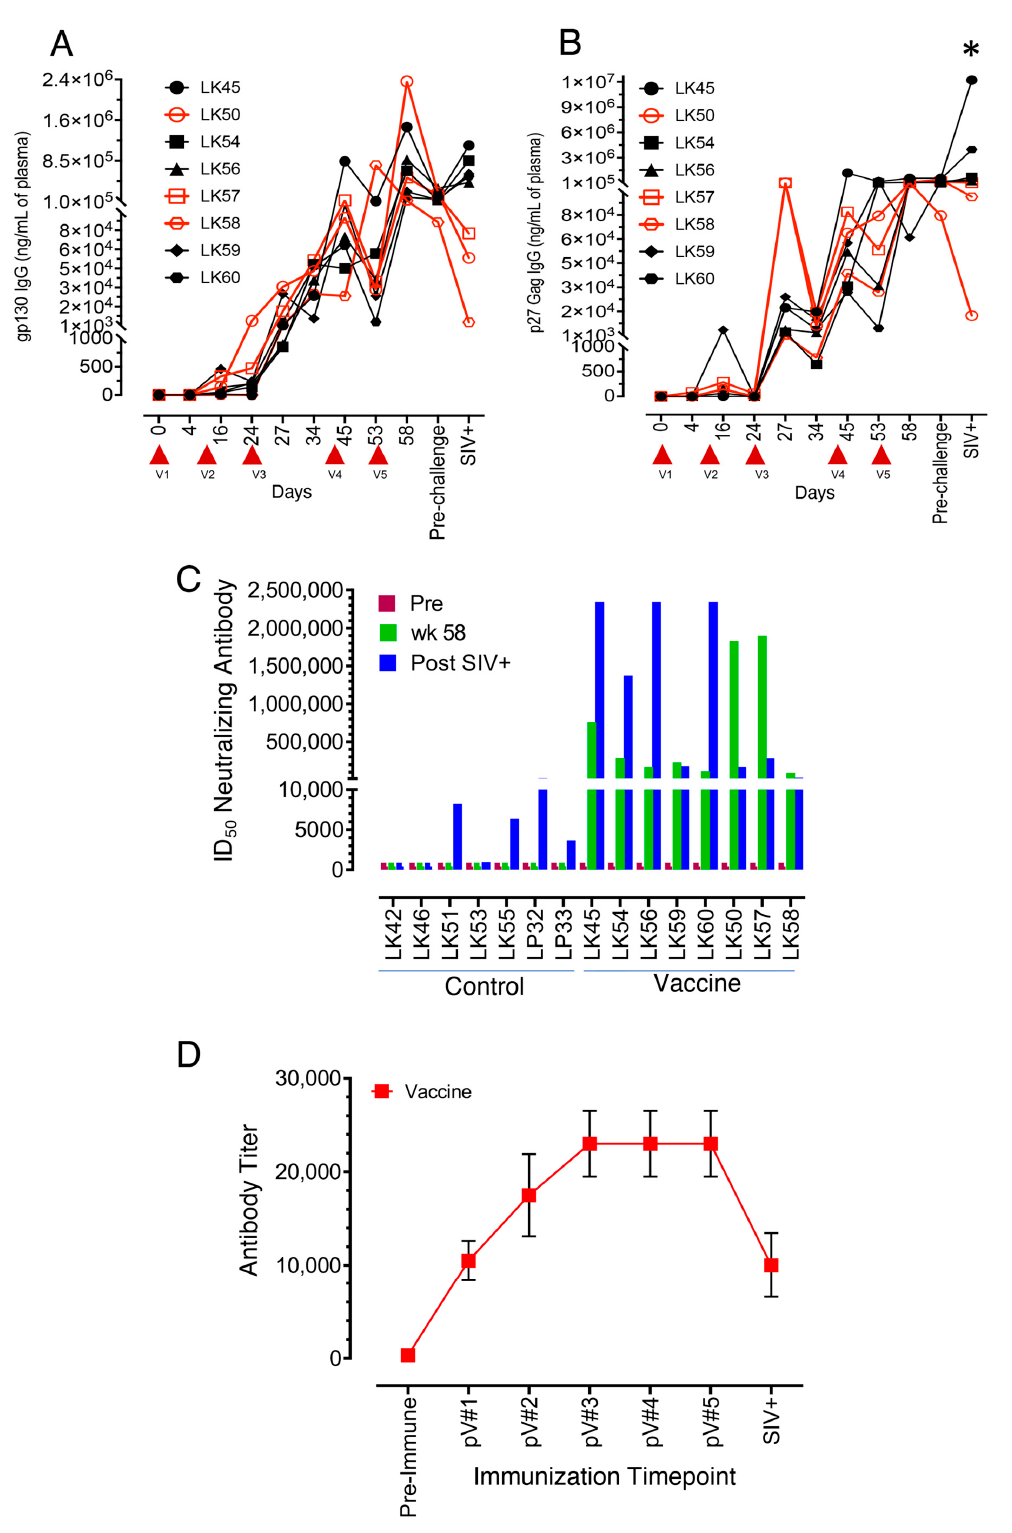
Figure 2. Humoral antibody responses in vaccine macaques. ( A , B ) Antigen-specific IgG responses measured over the vaccination and post challenge time points in all vaccinated macaques ( n = 8). Individual SIVgp130 ( A ) and SIVp27 ( B ) specific IgG responses are shown on the Y axis. Note that all vaccinated macaques had increased anamnestic IgG responses detected after second boost